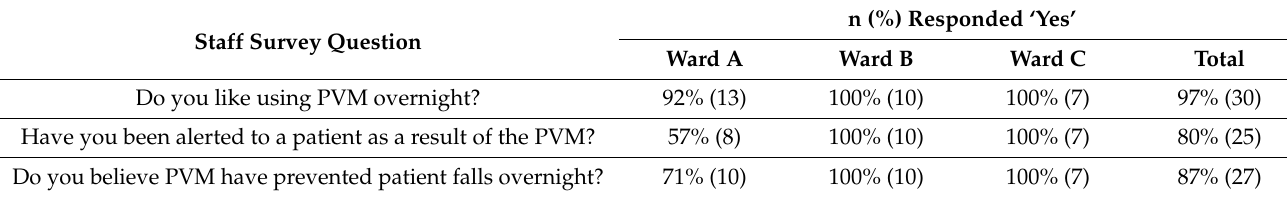
Table 4. Staff satisfaction survey results (n =